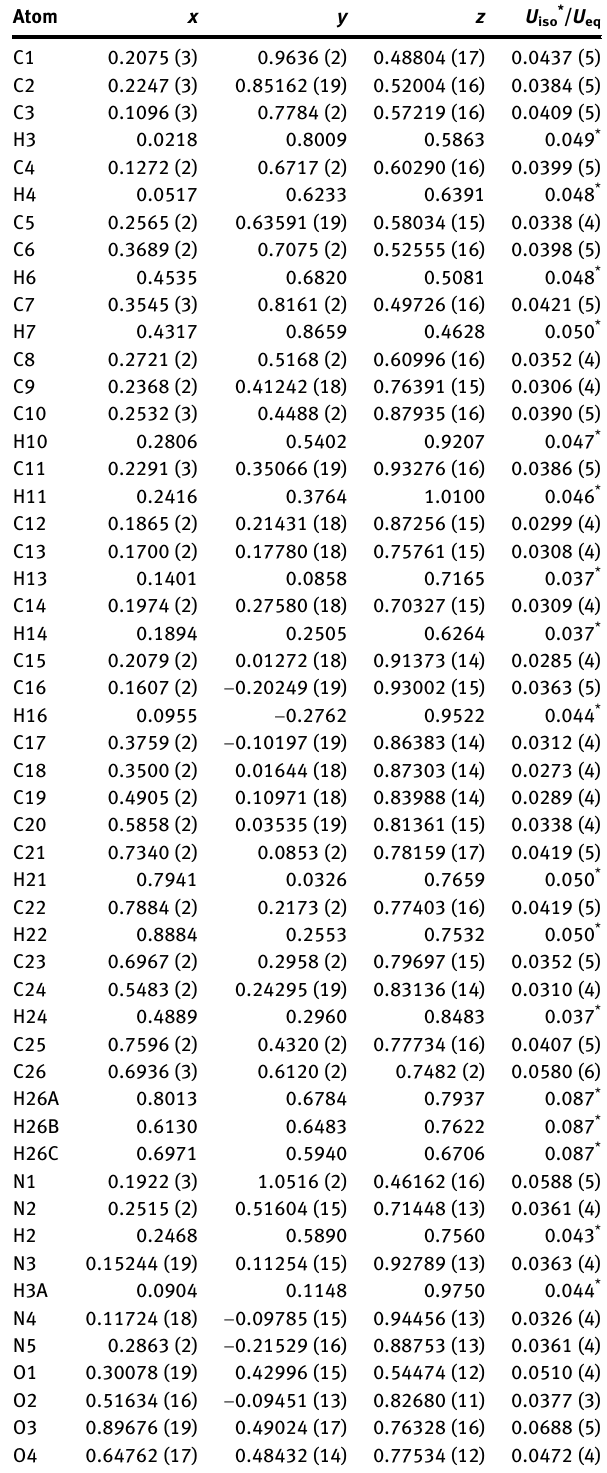
Table  : Fractional atomic coordinates and isotropic or equivalent isotropic displacement parameters (Å 